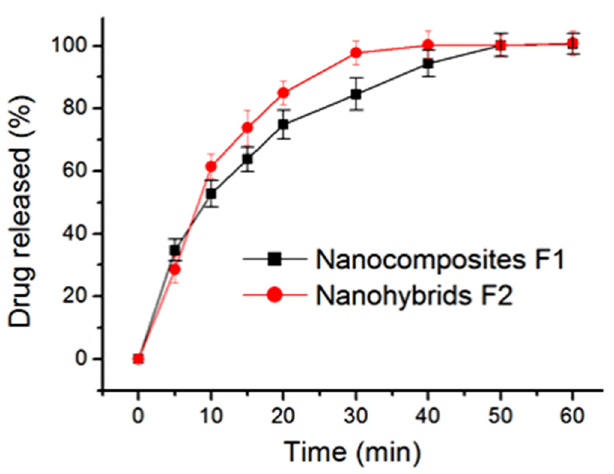
Figure 9. The in vitro dissolution tests of nanocomposites F1 and core–shell nanohybrids.